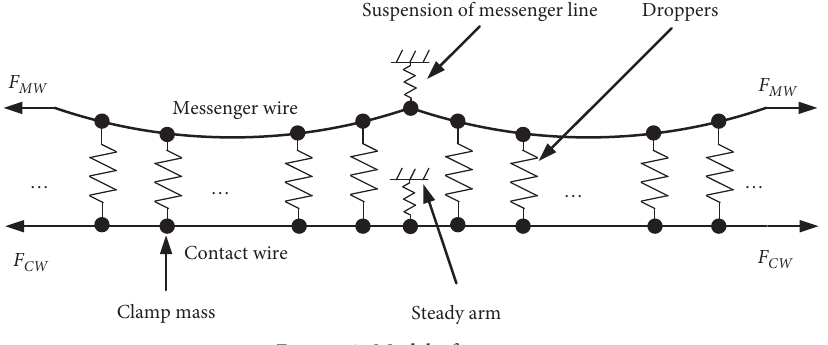
Figure 8: Model of